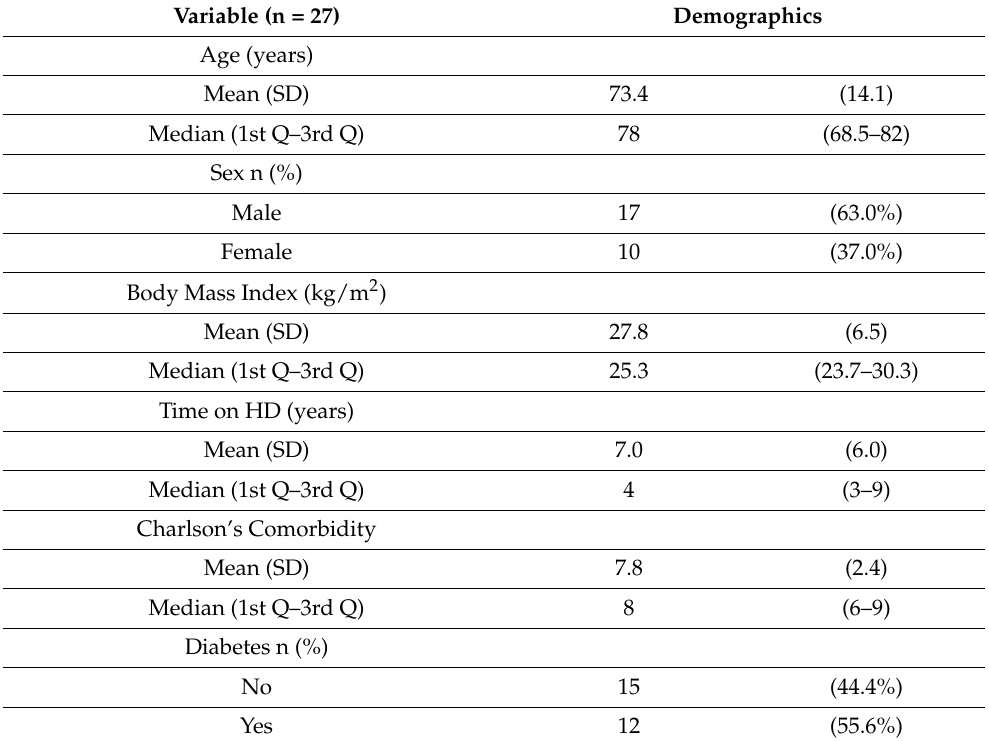
Table 1. Baseline clinical characteristics and demographics.